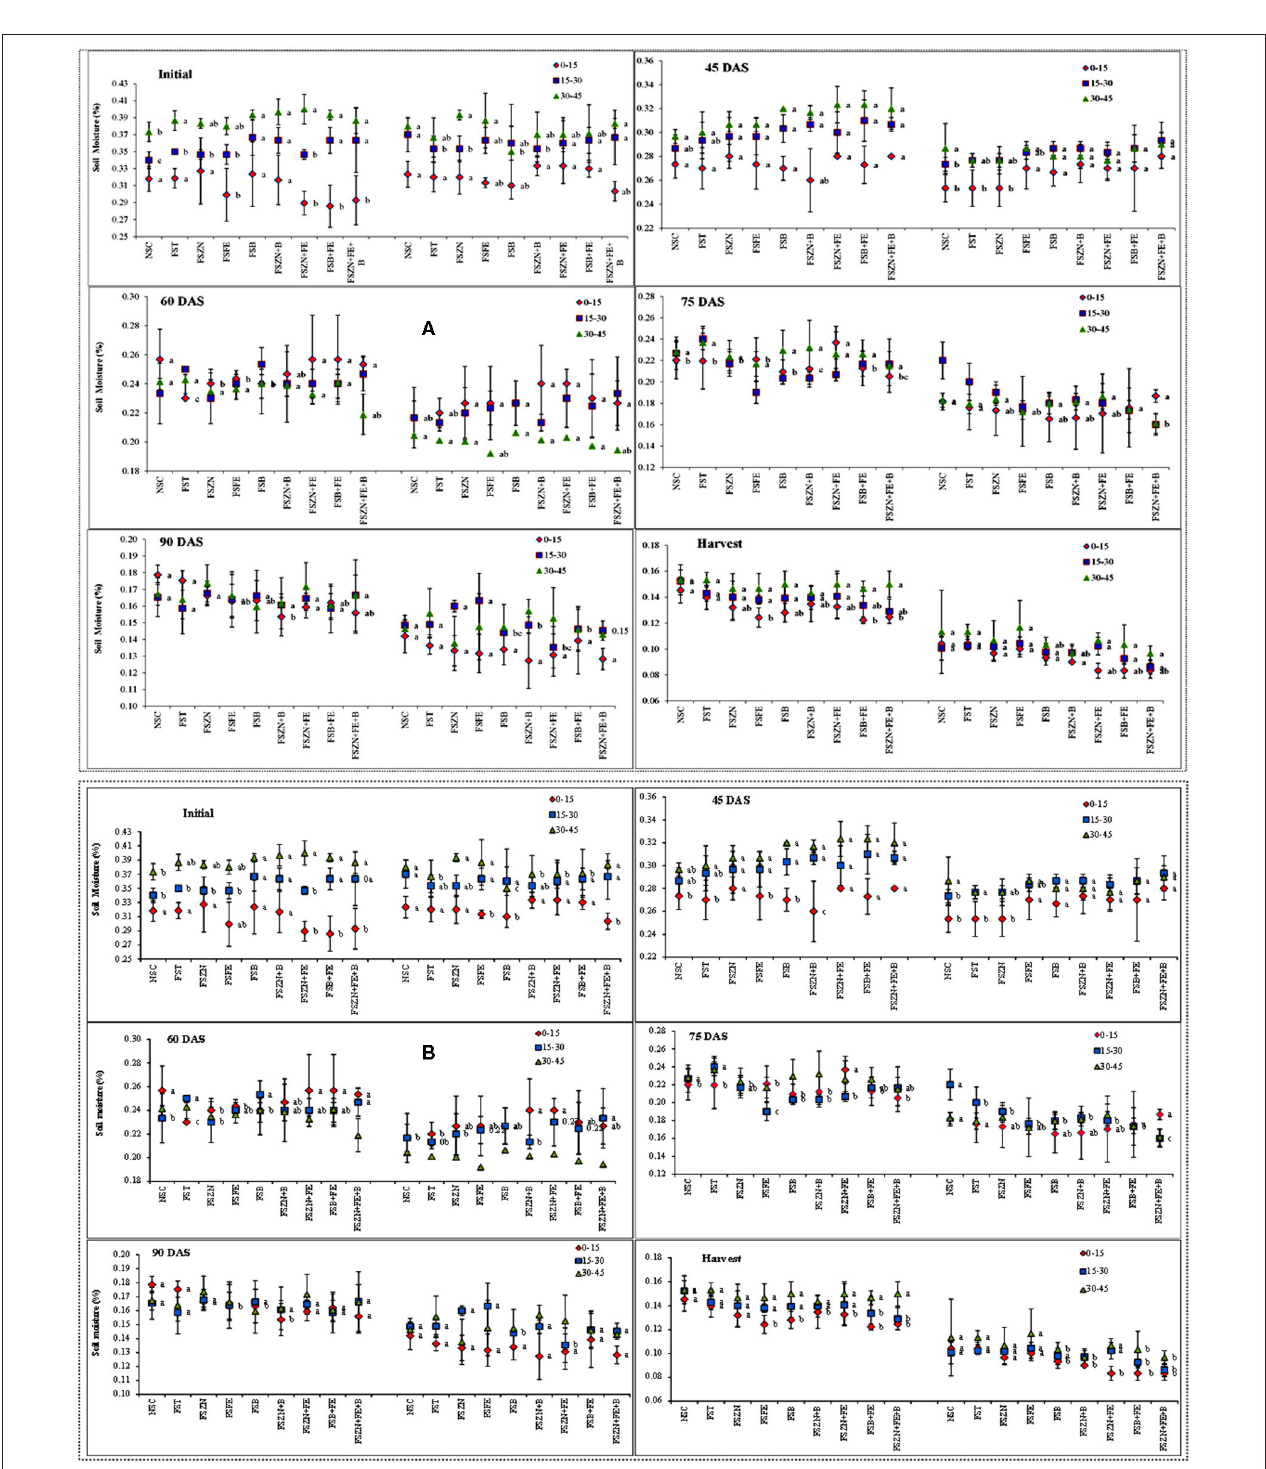
FIGURE 2 | (A) Soil moisture content at different growth periods under different dates of sowing and foliar spray (data of 2018–2019 crop season) (error bars represent the standard error of mean, and different letters indicate significant differences between means); and (B) soil moisture content at different growth periods under different dates of sowing and foliar spray (data of 2019–2020 crop season) (error bars represent the standard error of mean, and different letters indicate significant differences between means). Treatments details are available in Table 1 .